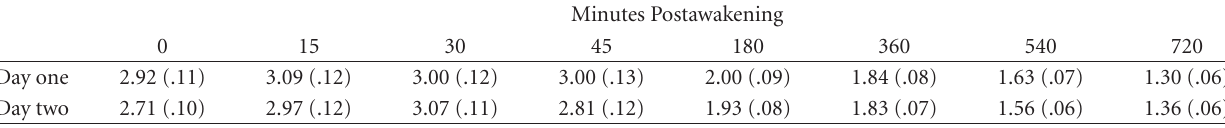
Table 2: Means (SEM) of salivary cortisol concentrations (sqrt nmol/L) across two days in healthy older people.